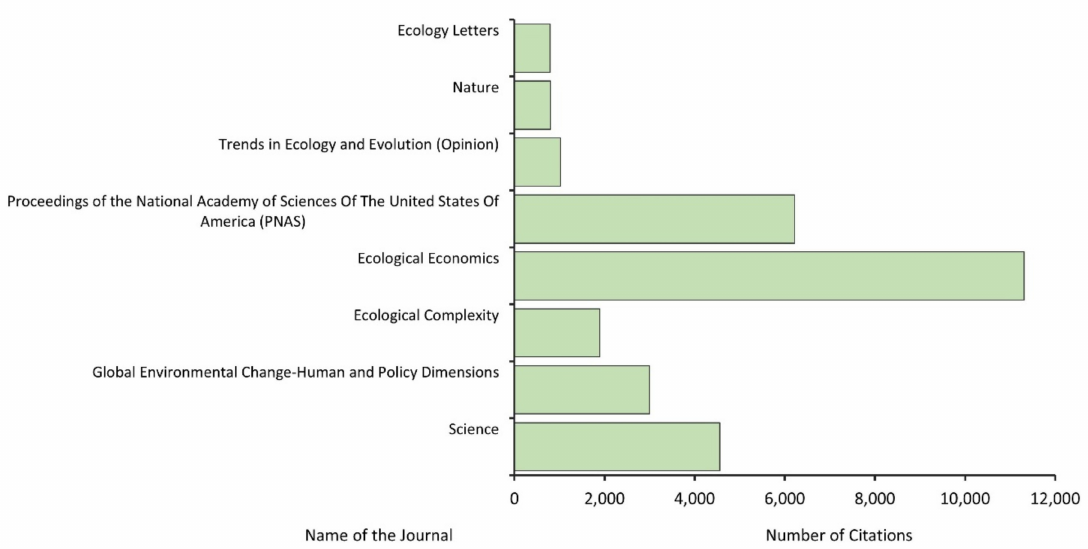
Figure 2. Number citations related to ecosystem services research in Web of Science Core Collection (WoSCC) database obtained by the highly cited journals from 2000 to